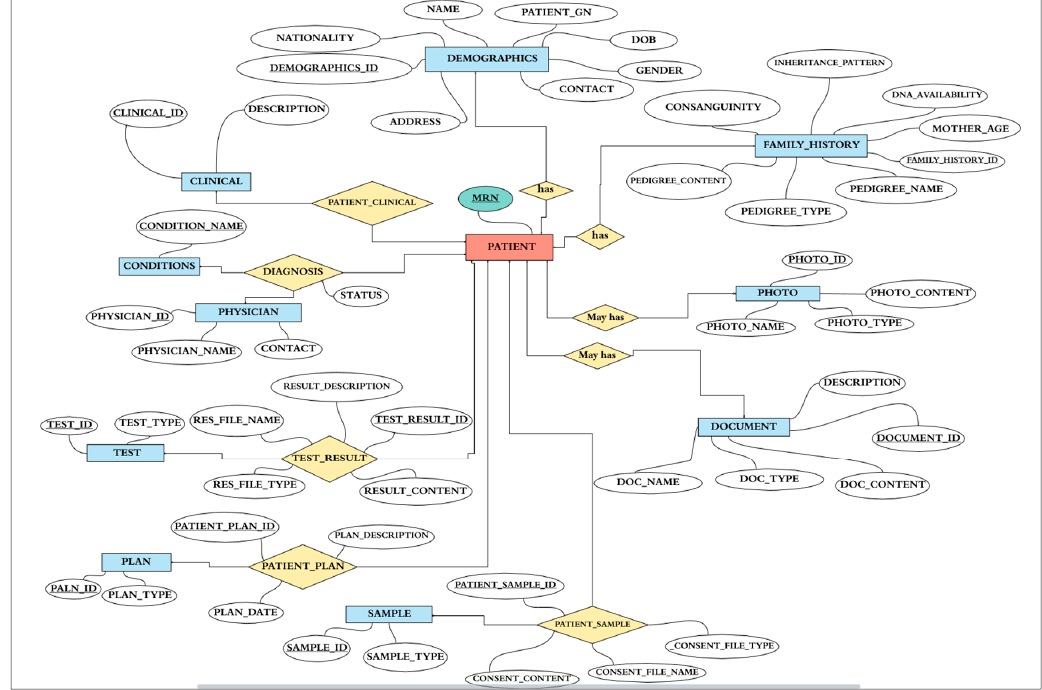
Figure 7. The entity-relationship diagram (ERD) (The Global Schema).